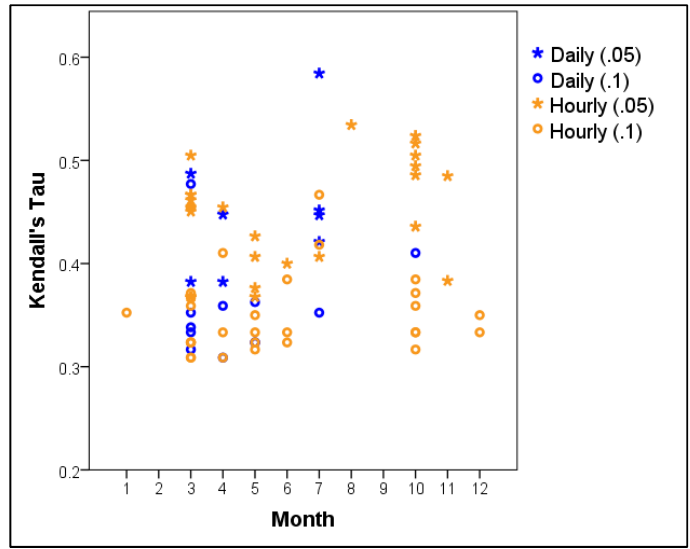
Figure 2. Kendall’s Tau for precipitation intensity trends at the 10% and 5% significance levels.